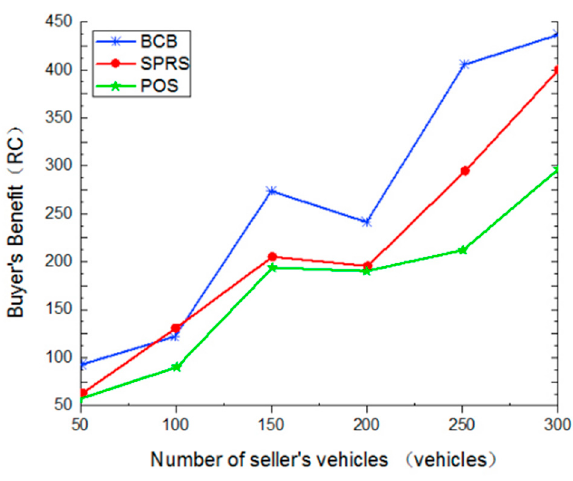
Figure 5. The impact of vehicle density on the buyer’s benefit.